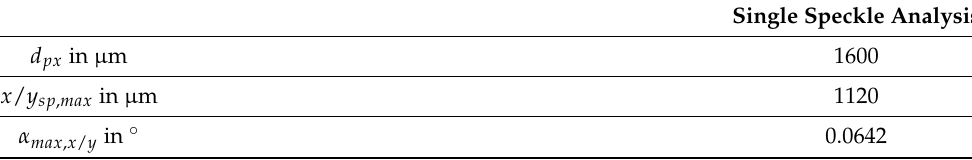
Table 3. Overview of the sensor size and surface tilt sensing ranges for the single speckle sensing ap-